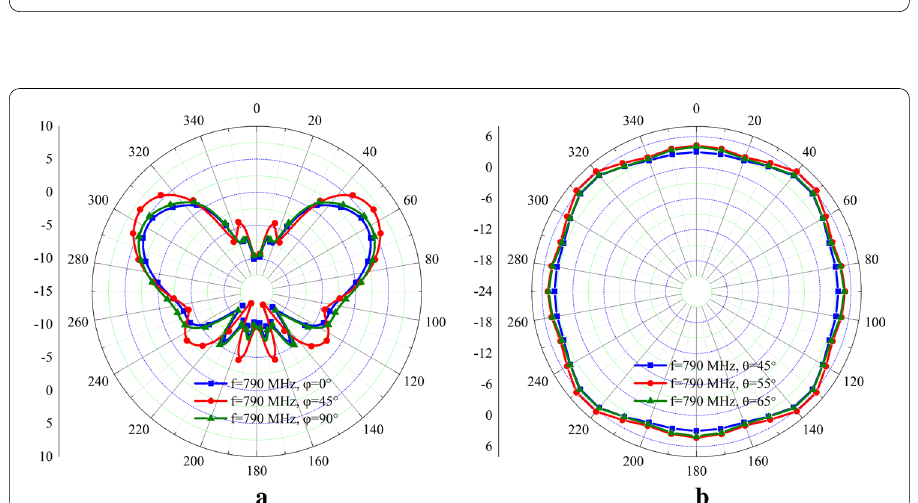
Fig. 7 The radiation pattern of antenna at 790 MHz. a Vertical radiation pattern. b Horizontal radiation